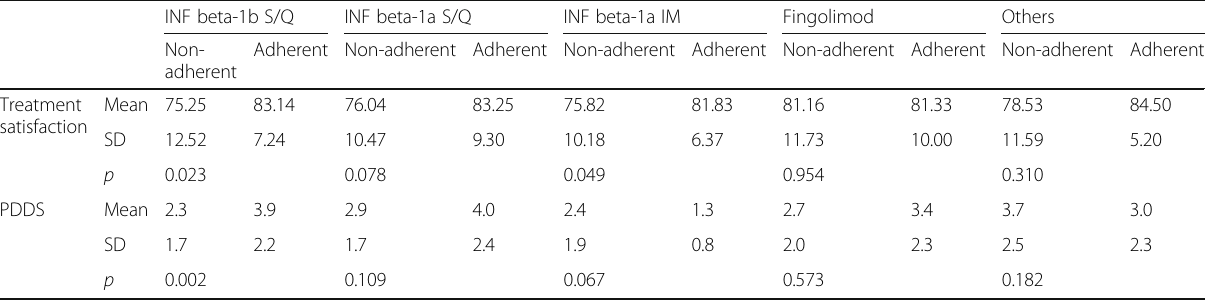
Table 2 Mean scores for MS patients ’ treatment satisfaction and PDDS according to their adherence to currently used drugs INF beta-1b S/Q INF beta-1a S/Q INF beta-1a IM Fingolimod Others Non- Adherent Non-adherent Adherent Non-adherent Adherent Non-adherent Adherent Non-adherent Adherent adherent Treatment Mean satisfaction